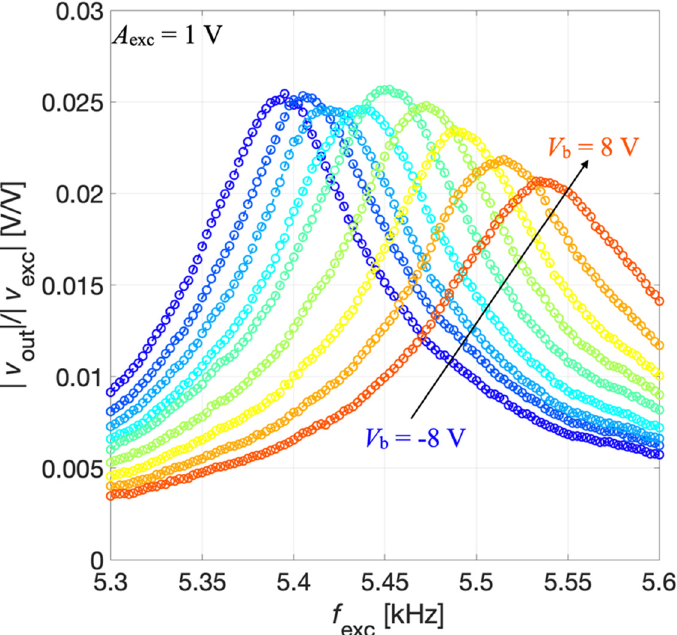
Figure 15. Measured magnitude ratio | v out |/| v exc | as a function of f exc for the acoustic transmitter mode at different values of V b .